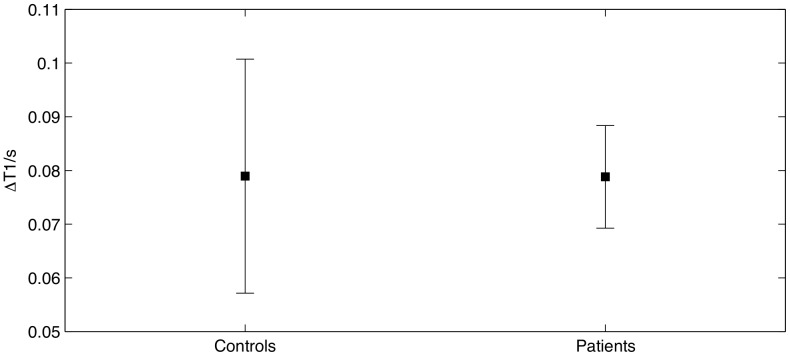
Change in T1 values caused by the injection of the contrast agent.The plot shows the mean change in T1 and 95% confidence intervals. We found no difference between the two groups when evaluating the effect of contrast agent on the T1 value.